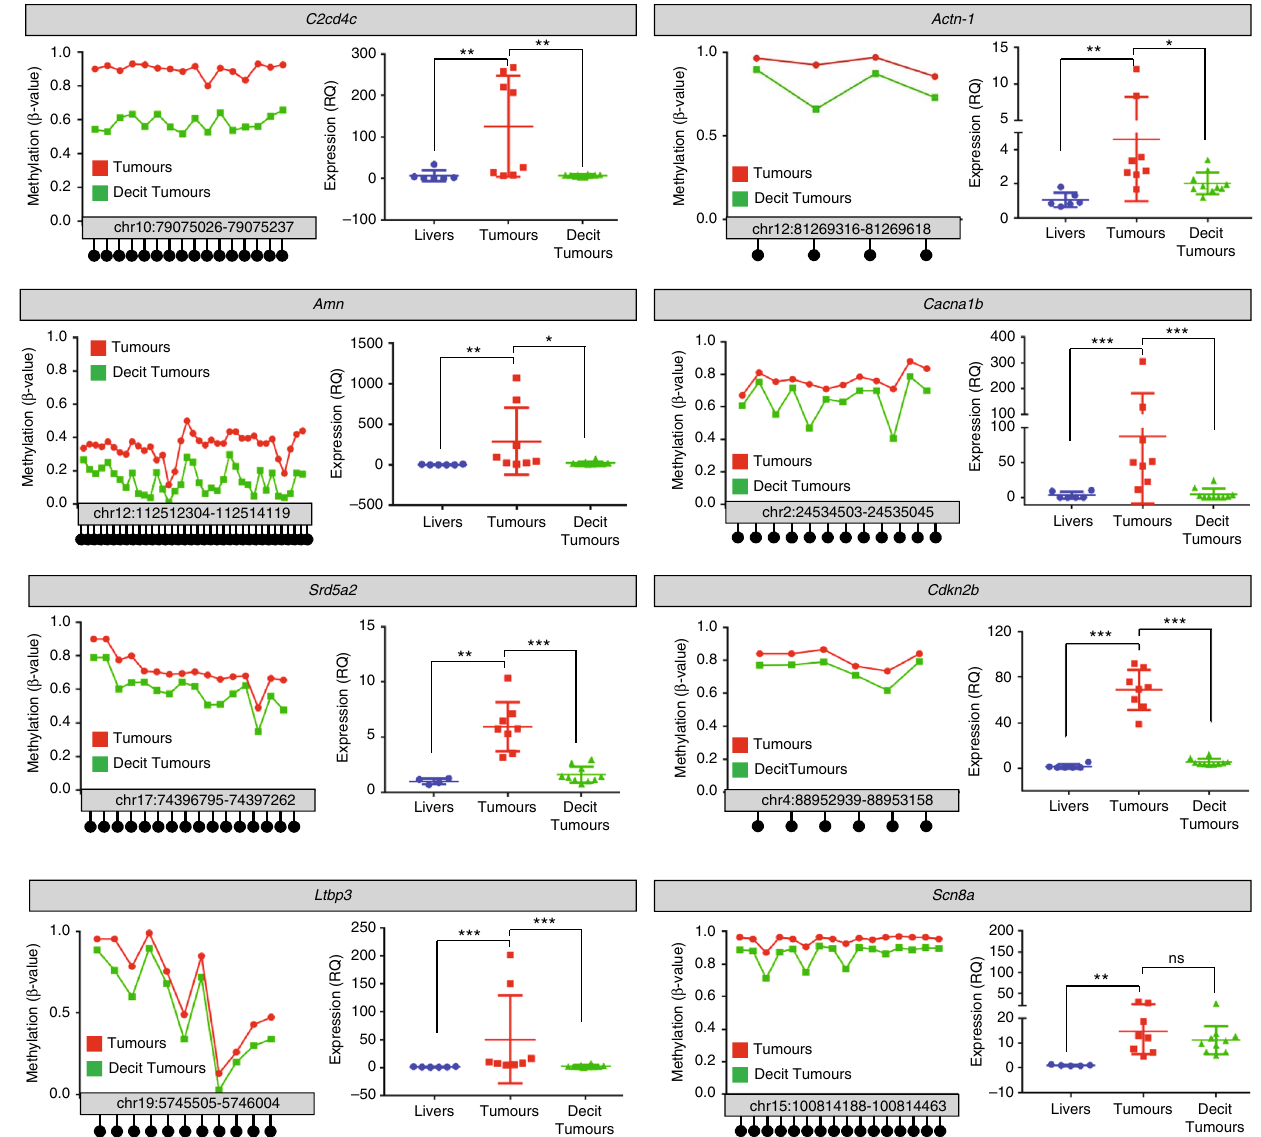
Fig. 4 Decitabine treatment decreases the expression and the CGI methylation levels of genes hypermethylated and overexpressed in Alb-R26 Met tumours. Expression and CGI methylation levels of a set of genes found hypermethylated and overexpressed in the Alb-R26 Met tumours were analysed in dissected tumours from Alb-R26 Met mice either untreated (red) or treated with Decitabine (green). For each indicated gene, graphs report the methylation levels of CpGs within the CGI of interest (left) and the expression levels of genes (right) in tumours from Alb-R26 Met mice either untreated (red) or treated with Decitabine (green), compared to control livers (blue). Note that demethylating treatment signi fi cantly decreased transcription levels. Concerning the Scn8a gene, the methylation levels of its gene body CGI was reduced in Decitabine treated tumours compared to untreated tumours. This was accompanied by a trend in downregulation of its expression levels, although not signi fi cant. It is possible that for Scn8a , the demethylation extent caused by the dose of Decitabine used is suboptimal to signi fi cantly in fl uence its expression levels. Alternatively, a more complex mechanism could be involved in the regulation of Scn8a expression. Signi fi cance is indicated on the top. Not signi fi cant (ns): P > 0.05, * P < 0.05, ** P < 0.01, *** P <